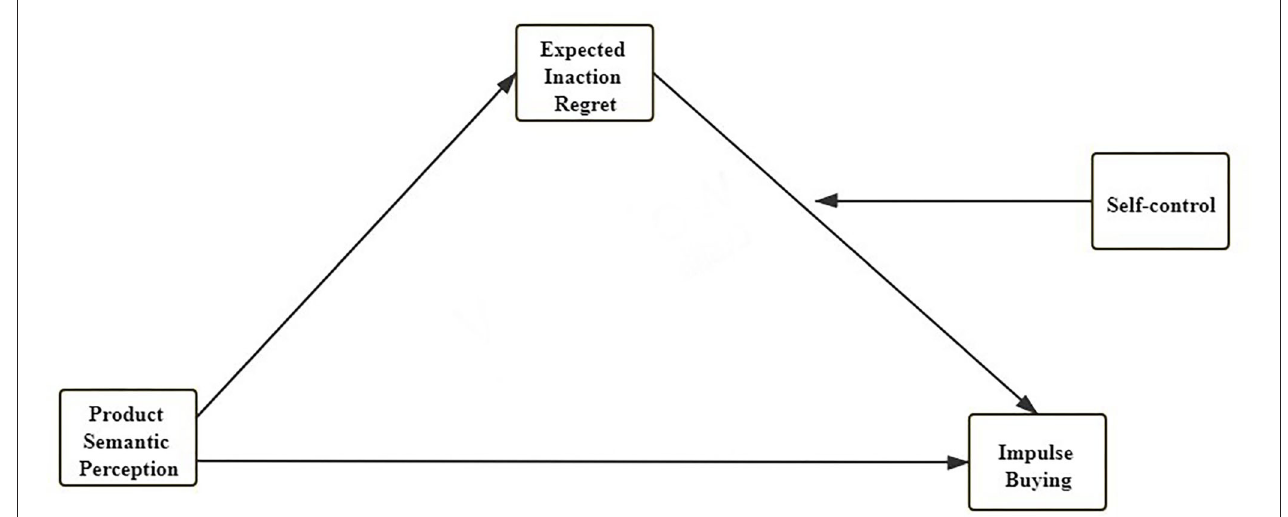
FIGURE 1 | Conceptual